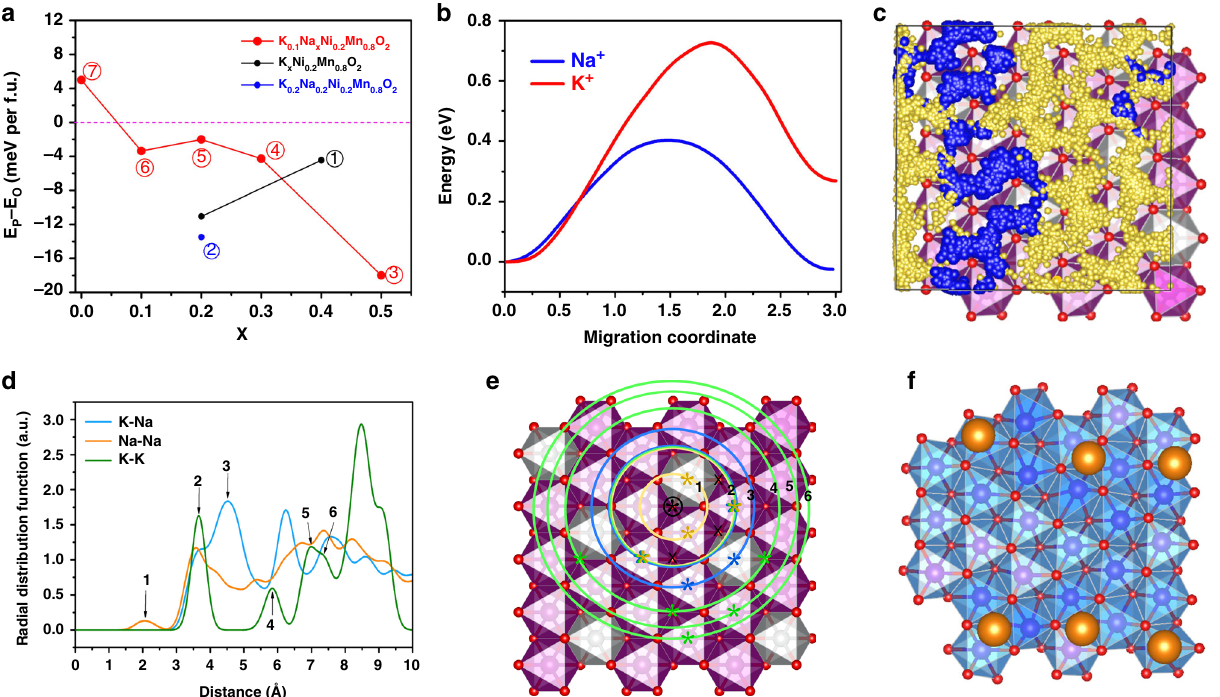
Fig. 6 DFT calculations. a Energy difference between P2 and O2 phase of each composition found during the cell operation. b Na + and K + vacancy hopping energy barriers. c Trajectories of Na + /K + ion diffusion in the alkali metal layer in P2- K 0.1 Na 0.3 Ni 0.2 Mn 0.8 O 2 from AIMD simulations. d Radial distribution function (RDF) for the alkali ions. e Comparison between the RDF peak positions and the a – b plane of the crystal lattice. f Distribution of K ions after structural relaxation. Inter-K distances are all larger than the inter-site distance even if they are put closer at the beginning of the structural